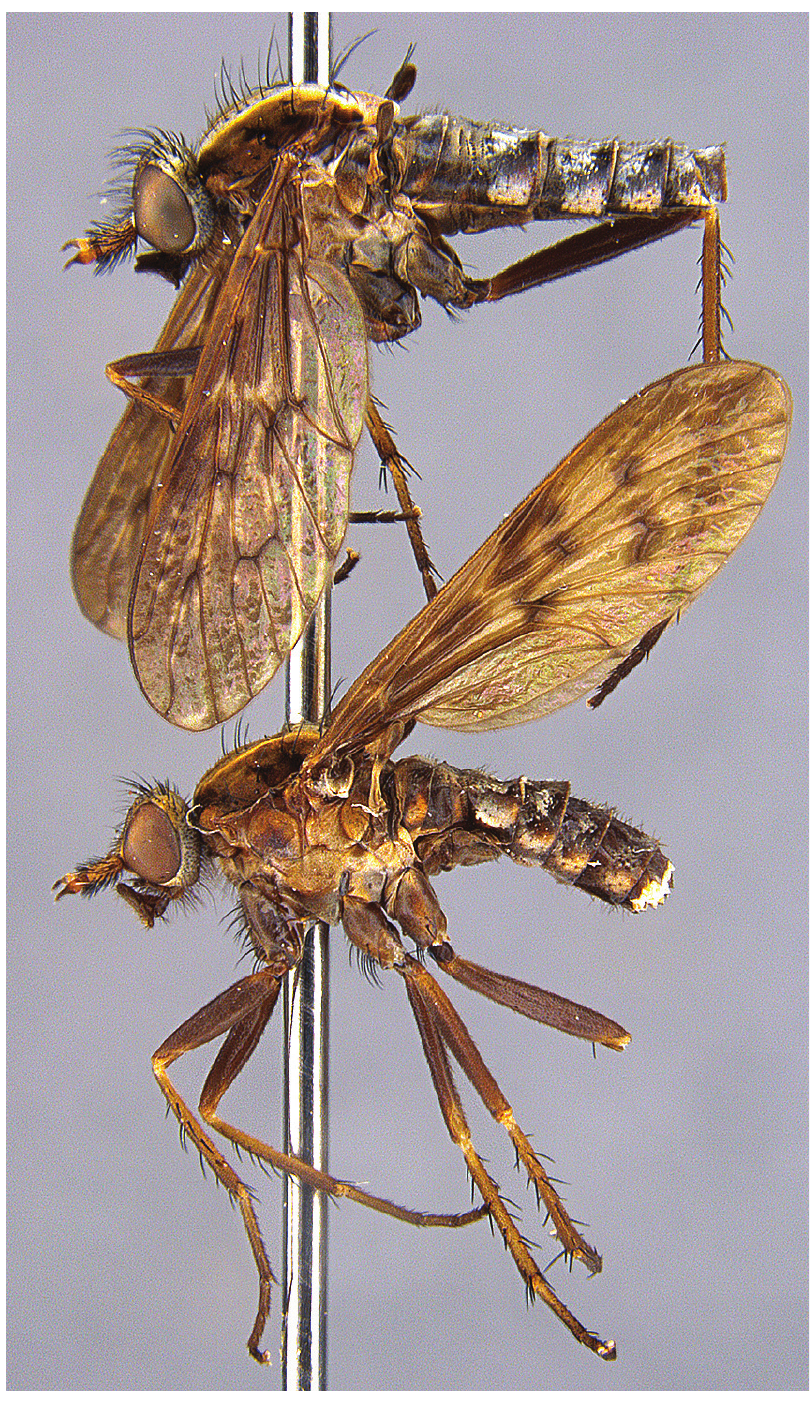
Figure 18. Sidarena yallingup sp. n.: Male (upper) and female (lower), lateral view (terminalia